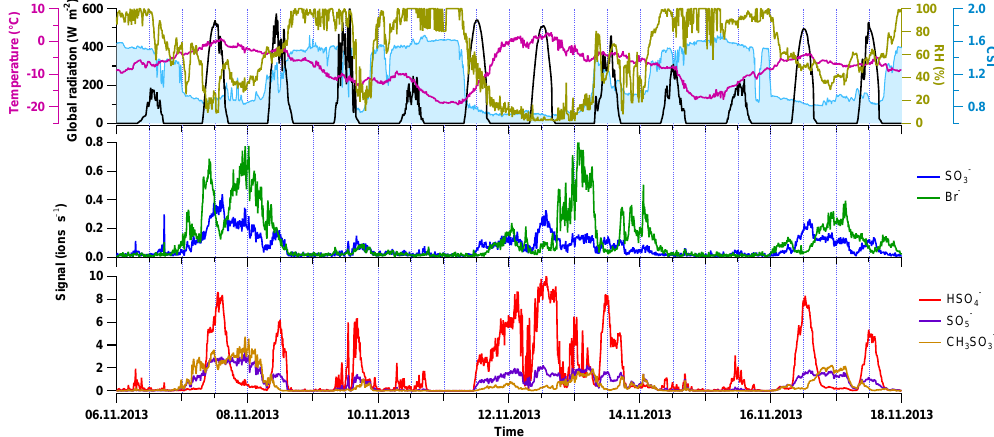
Figure 3. Time series of major ions and meteorological parameters from 6 to 18 November. Upper panel: global radiation (Wm − 2 ), air temperature ( ◦ C), relative humidity (%) and clear sky index (CSI). Middle and lower panel: Br − , SO −